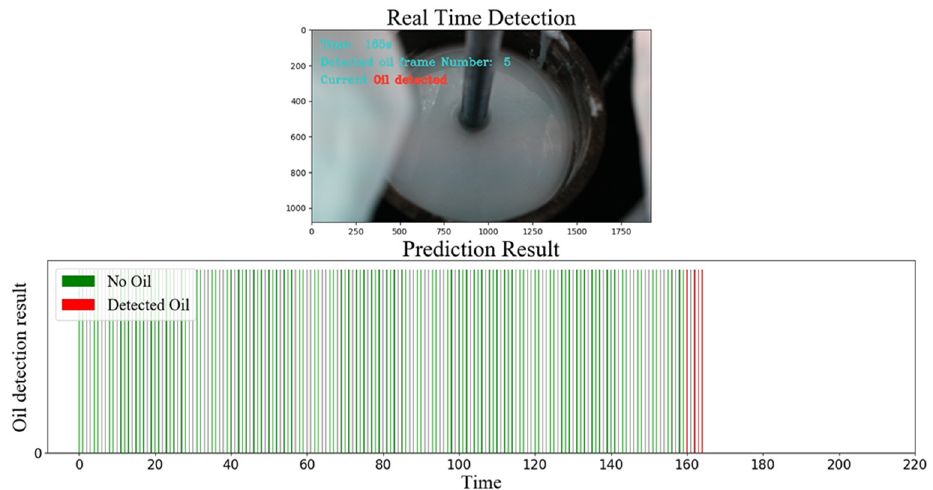
Figure 6. VOS-Net prediction window and result; a demo of VOS-Net result is available at https://youtu.be/kCZnMAYBByk (accessed on 15 July 2022). //youtu.be/kCZnMAYBByk (accessed on 15 July